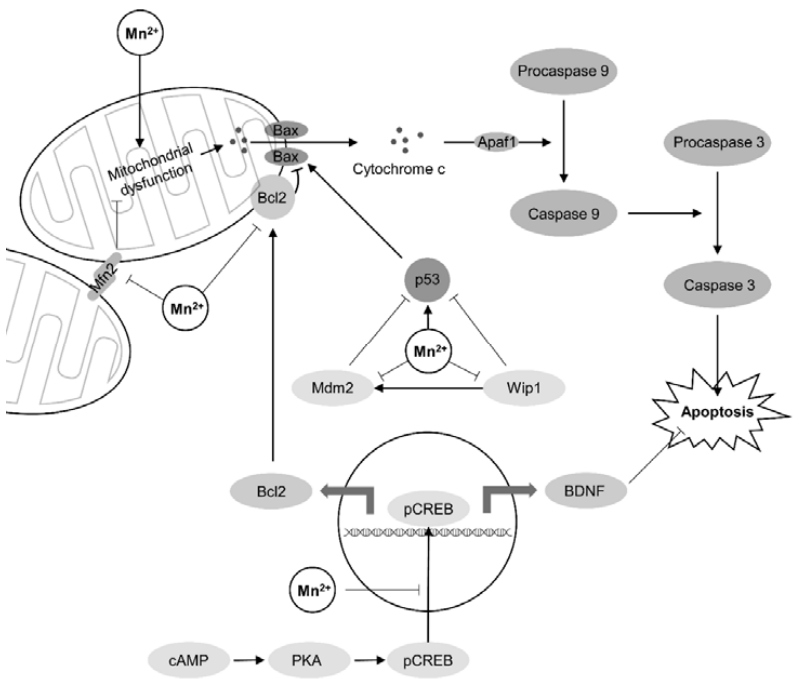
Figure 3. Mechanisms of Mn-induced apoptosis. Mn exposure results in mitochondrial dysfunction and Bax-associated cytochrome c leakage with subsequent caspase 9 and 3 activation resulting in apoptosis. Mn-induced apoptosis may be aggravated by stimulatory effects of manganese on p53 protein as well as down-regulation of murine double minute 2 (Mdm2) homolog and wild-type p53-induced phosphatase 1 (Wip1) protein, both having inhibitory influence on p53 [140]. The impact of Mn on p53 signaling may be also mediated by Mn-dependent modulation of ataxia telangiectasia mutated (ATM) kinase [71]. In turn, Mn may decrease anti-apoptotic effects of Bcl2 and BDNF through inhibiting CREB phosphorylation and subsequent down-regulation of Bcl2 and BDNF expression [137]. It has been also demonstrated that mitochondrial pathway of apoptosis may be also aggravated by Mn-induced alteration of mitofusin 2 (Mfn2) expression, a protein involved in mitochondrial fusion and functioning